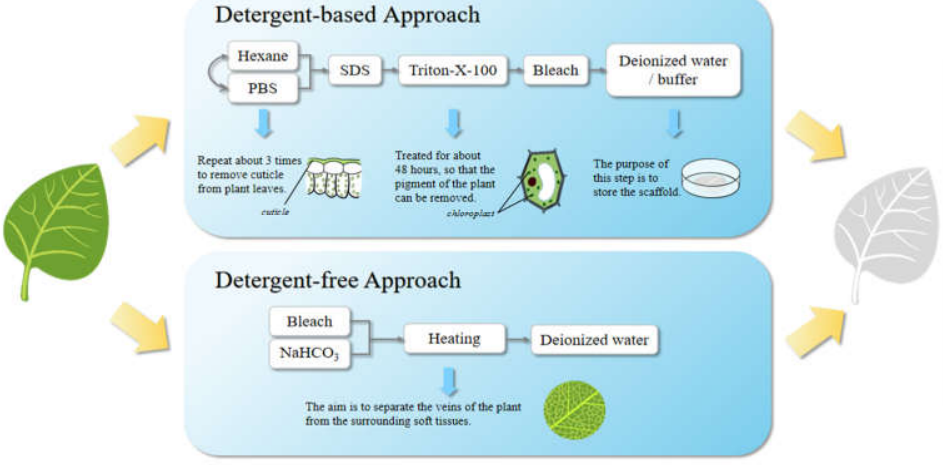
Figure 3. The methods for the preparation of plant-derived decellularized scaffolds.